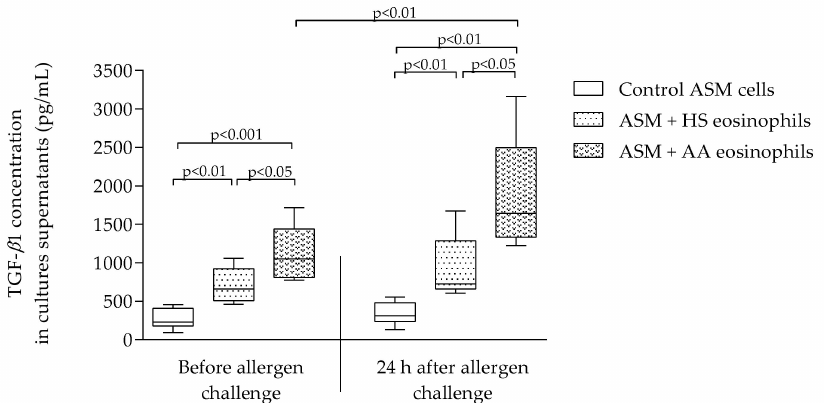
Figure 3. TGF- β 1 concentration in supernatants of control ASM cell culture, ASM cells with HS eosinophils as well as ASM cells with AA eosinophils combined cultures before and 24 h after allergen challenge. Data represented as median (range). AA—allergic asthma; ASM—airway smooth muscle cells; HS—healthy subject; TGF- β 1—transforming growth factor β 1; control ASM cells that were not incubated with eosinophils, AA n = 8, HS n = 7. Statistical analysis—Mann–Whitney U test for analysis between control ASM cells, AA and HS; Wilcoxon matched-pairs signed-rank test for analysis between the dependent groups. Lines connect comparison groups with p -value denoting the significant di ff erence in pair-wise